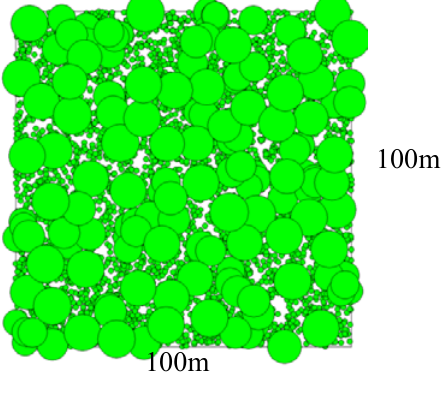
Figure 1. The managed beech stand 125 years after planting containing a dominant tree layer and a regeneration layer in the understory. The figure is generated by Silva